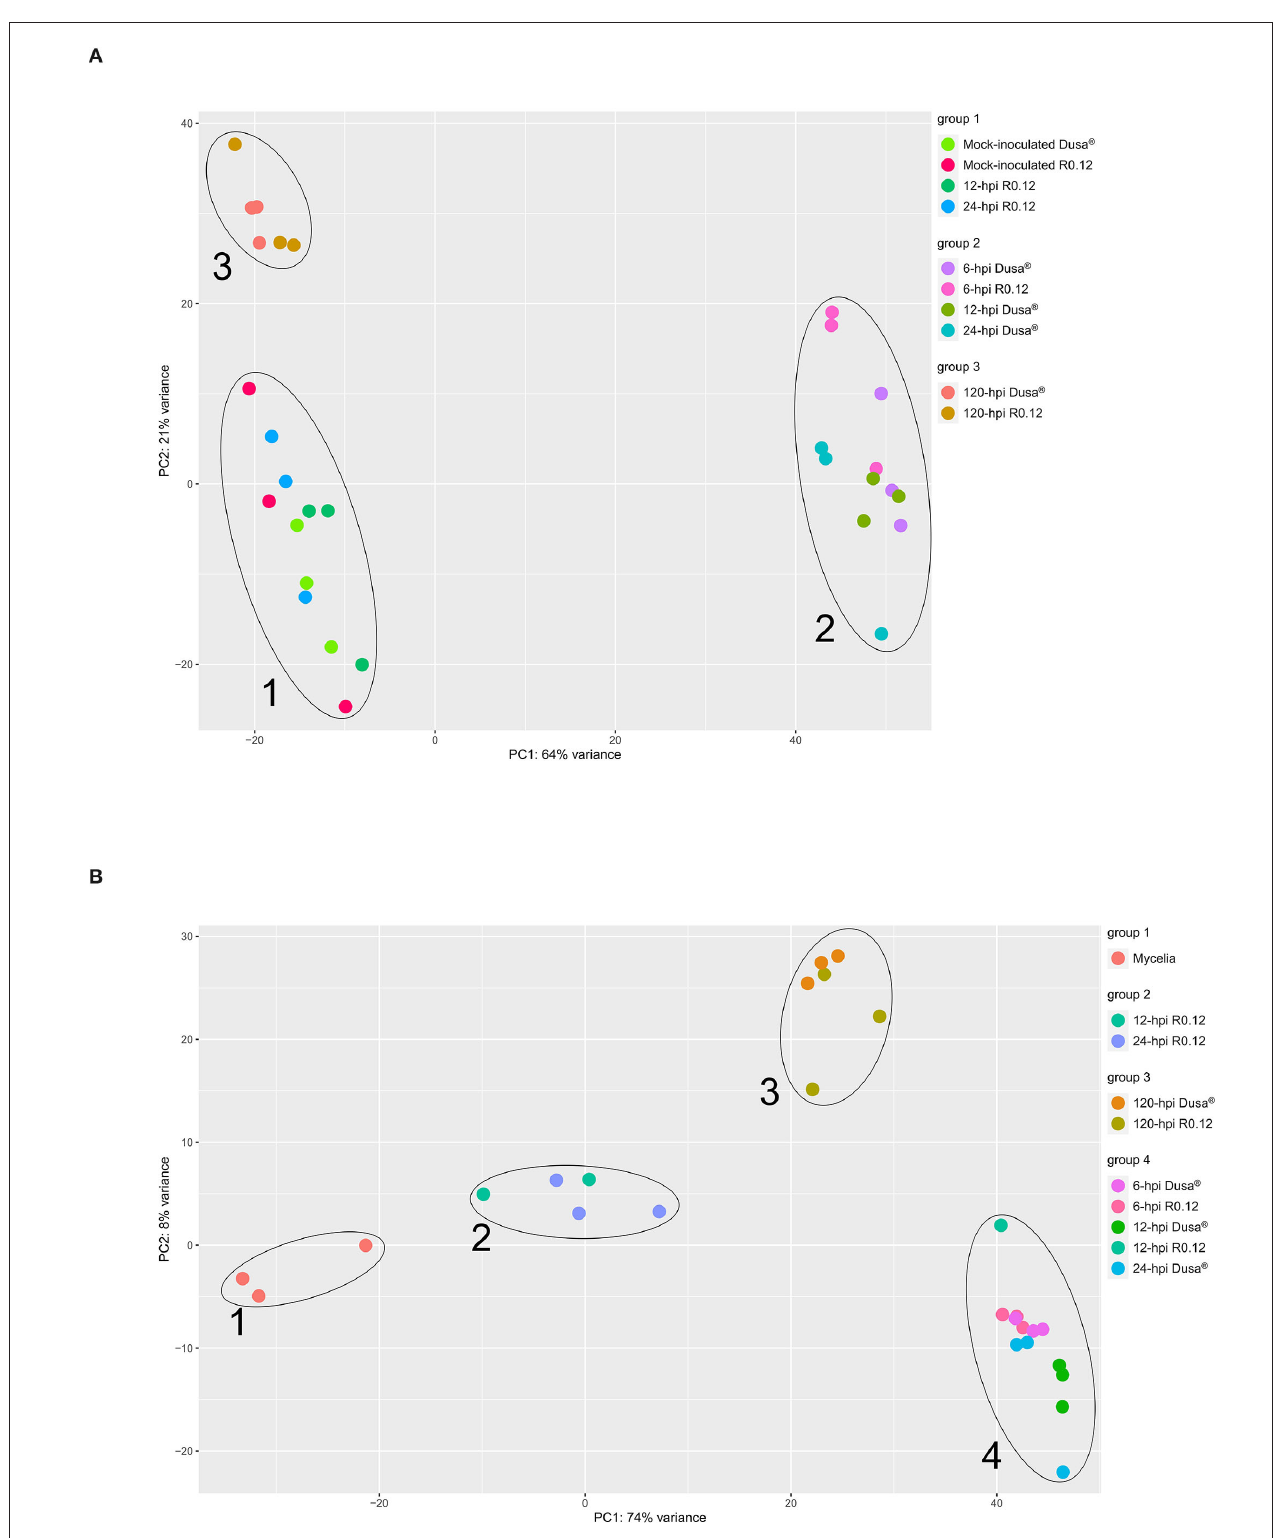
FIGURE 2 | Principal component analysis (PCA) representing variation in gene expression. Expression values were obtained following differential gene expression analyses and variance stabilized transformation. Principal component 1 (PC1) and PC2 were arbitrarily assigned to either axis and represent the total